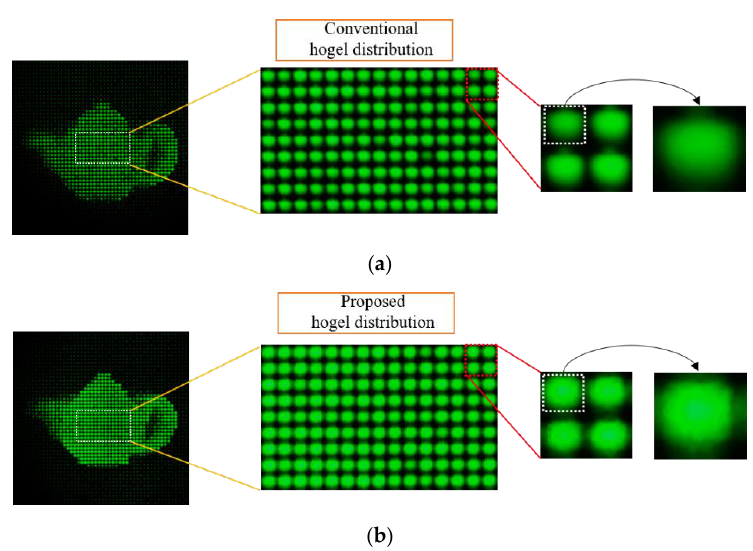
Figure 13. Spatial resolution comparison: ( a ) conventional method and ( b ) proposed method.